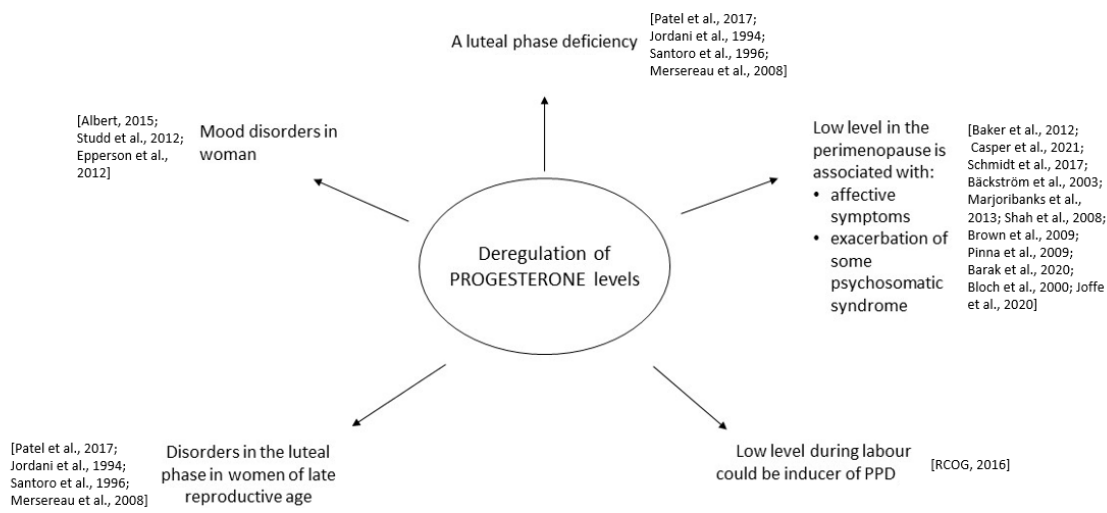
Figure 2. Deregulation of progesterone levels and connection with health disorders